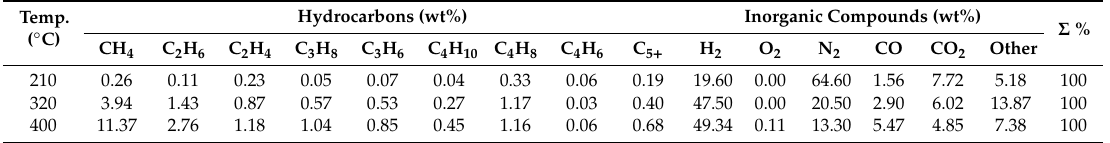
Table 2. Gas composition, preconsumer material, 400 °C.